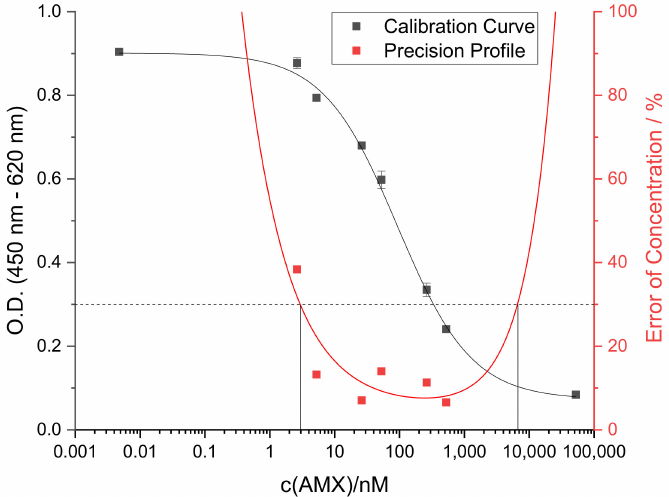
Figure 5. Calibration curve (black) and precision profile (red) for the quantification of AMX, indicating the measurement range of the assay to reach from AMX concentrations of 3 nM up to 7 µ